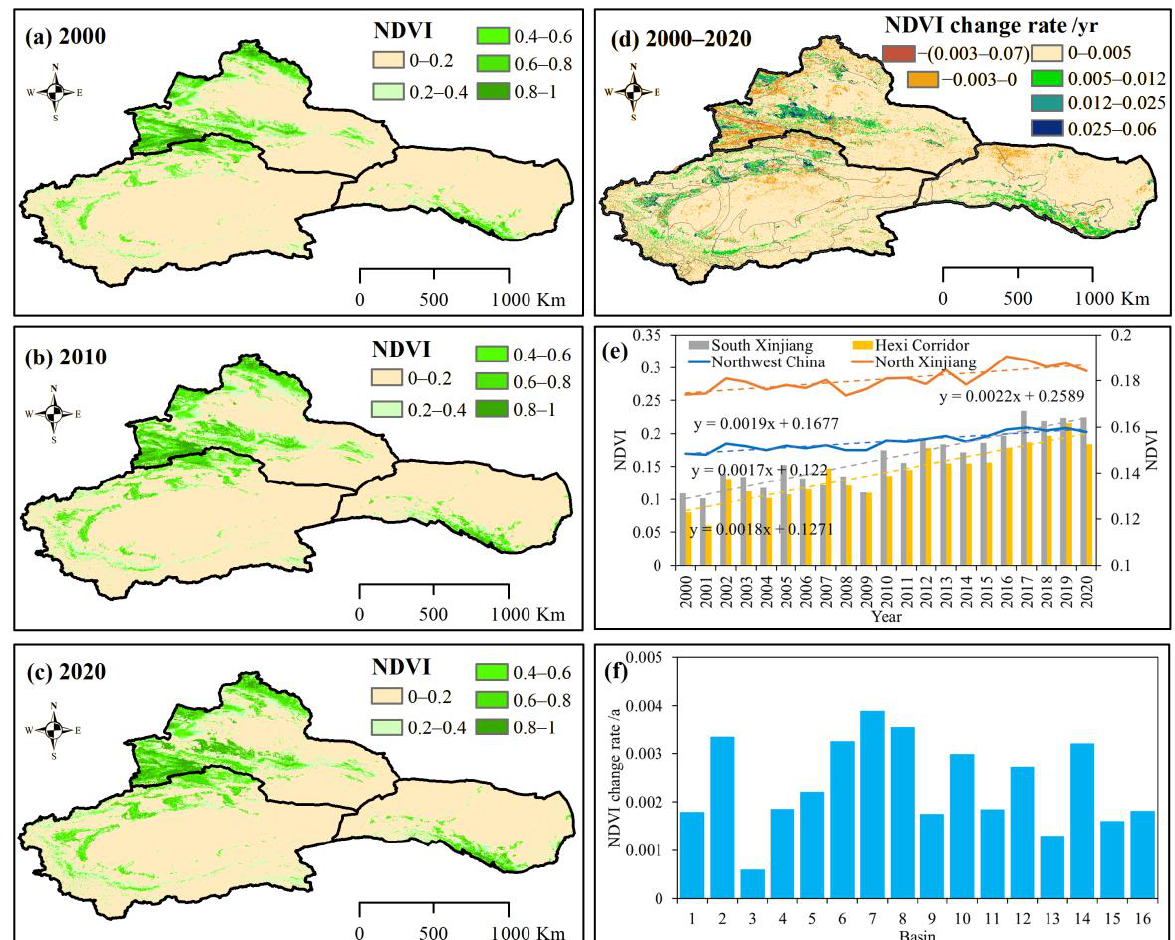
Figure 7. Spatial distribution and variations of NDVI from 2000 to 2020. Spatial distribution of NDVI during ( a ) 2000, ( b ) 2010, and ( c ) 2020; ( d ) spatial variations of NDVI in NWC; ( e ) temporal variations of NDVI in NWC, SXJ, NXJ and HX; ( f ) spatial variations of NDVI across different basins in NWC: (1) Irtysh River basin, (2) Emin River basin, (3) Ili River basin, (4) Kaidu River basin, (5) Kongqi River basin, (6) Dina River basin, (7) Weigan-Kuche River basin, (8) Aksu River basin, (9) Keriya River basin, (10) Kashgar River basin, (11) Hotan River basin, (12) Yarkand River basin, (13) Qarqan River basin, (14) Shiyang River basin, (15) Shule River basin, and (16) Heihe River basin. From 2000 to 2020, the FVC in NWC showed a significant increasing trend (0.20% yr − 1 , p < 0.01), expanding from 16.96% in 2000 to 20.28% in 2020. Spatially, the FVC in NXJ,